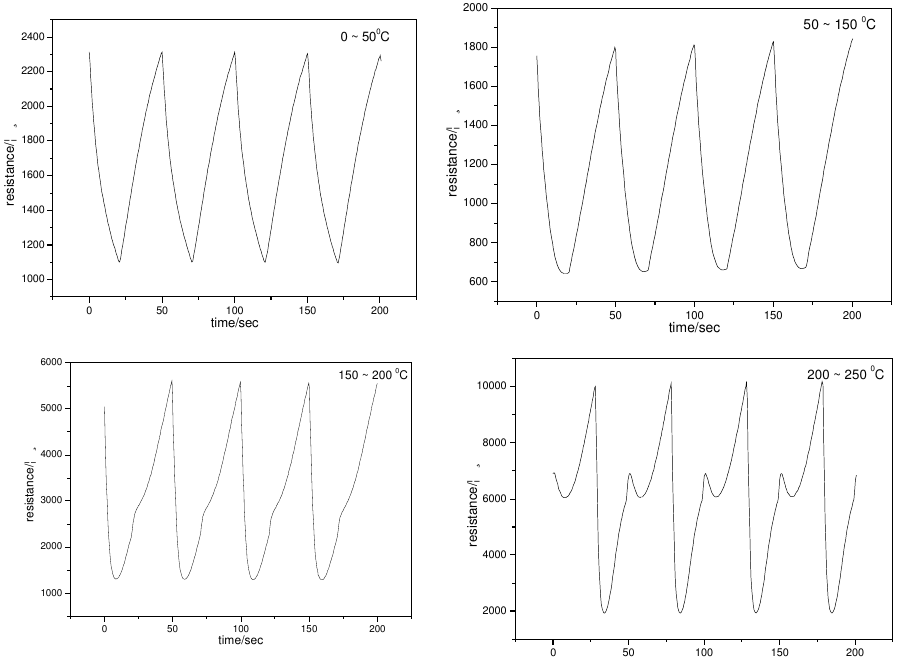
Figure 5. Effect of temperature on the response of 0.1ppm trichlorphon gas under frequency